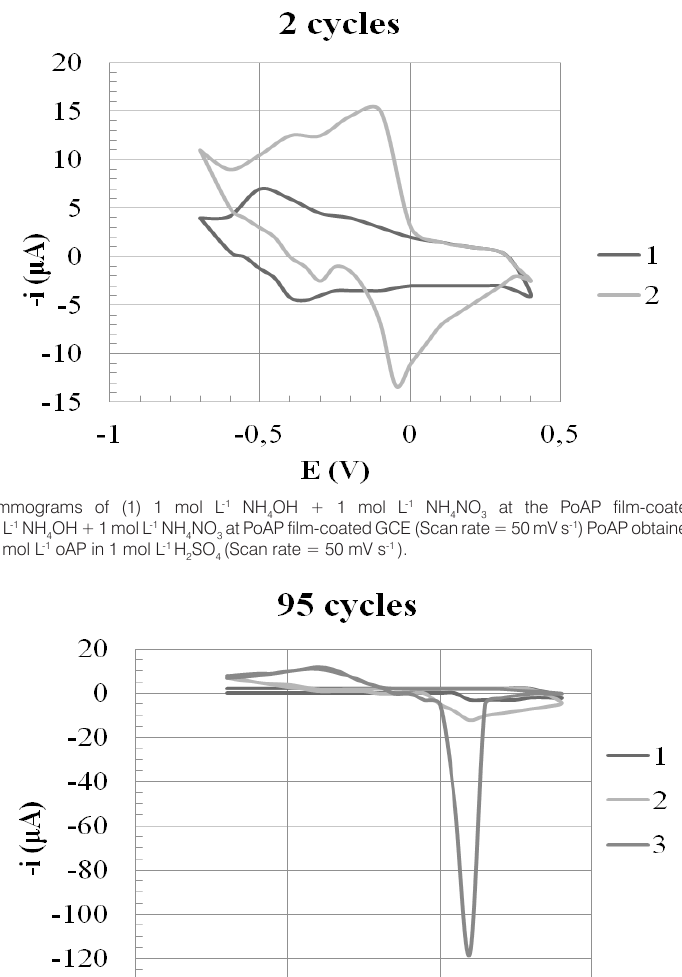
SO at PoAP film-coated GCE, (2) 1×10 -3 mol L -1 Cu 2+ + 1 mol L -1 H 2 4 SO at GCE. (Scan rate = 50 mV s -1 ) PoAP obtained film after 95th polymerization cycle 2 4